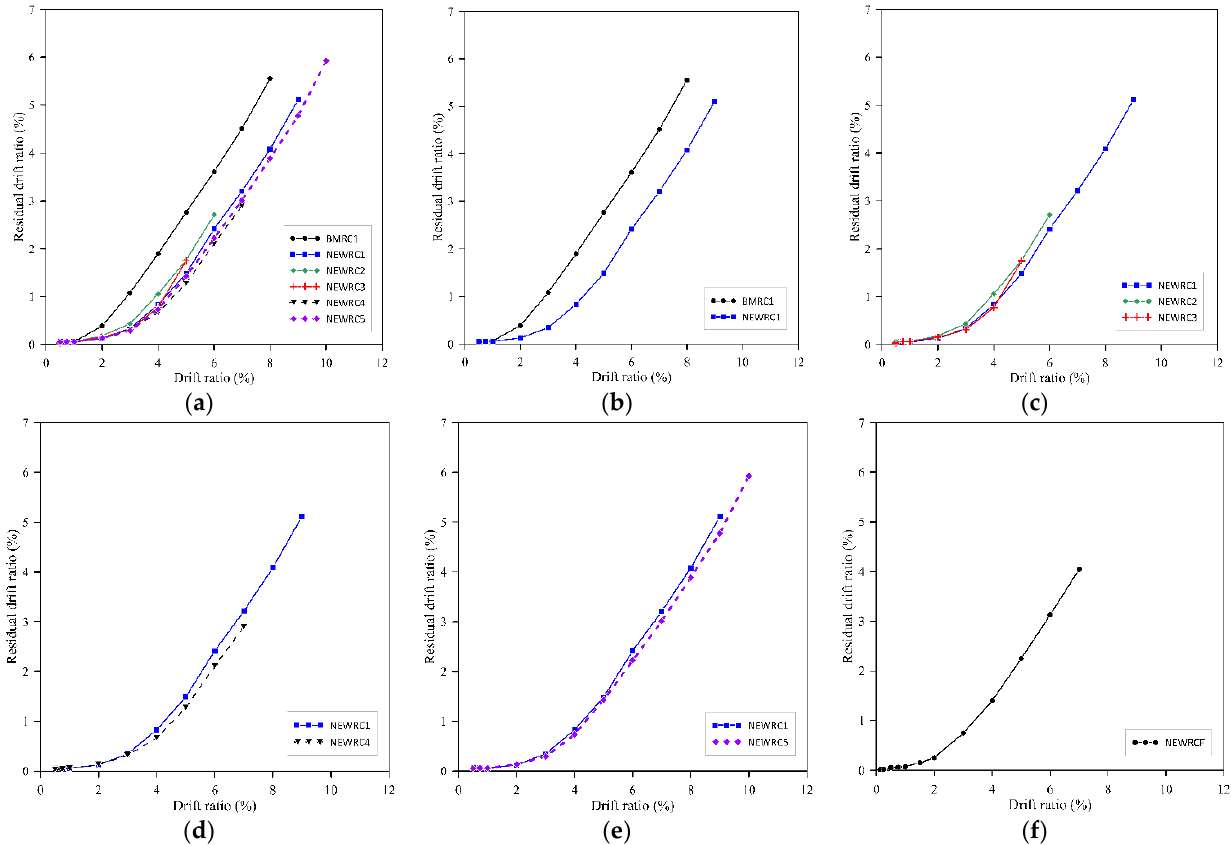
Figure 14. Residual drift ratios at different drift ratios: ( a ) All column specimens; ( b ) BMRC1 and NEWRC1; ( c ) NEWRC1, 2, and 3; ( d ) NEWRC1 and 4; ( e ) NEWRC1 and 5; ( f ) NEWRCF.